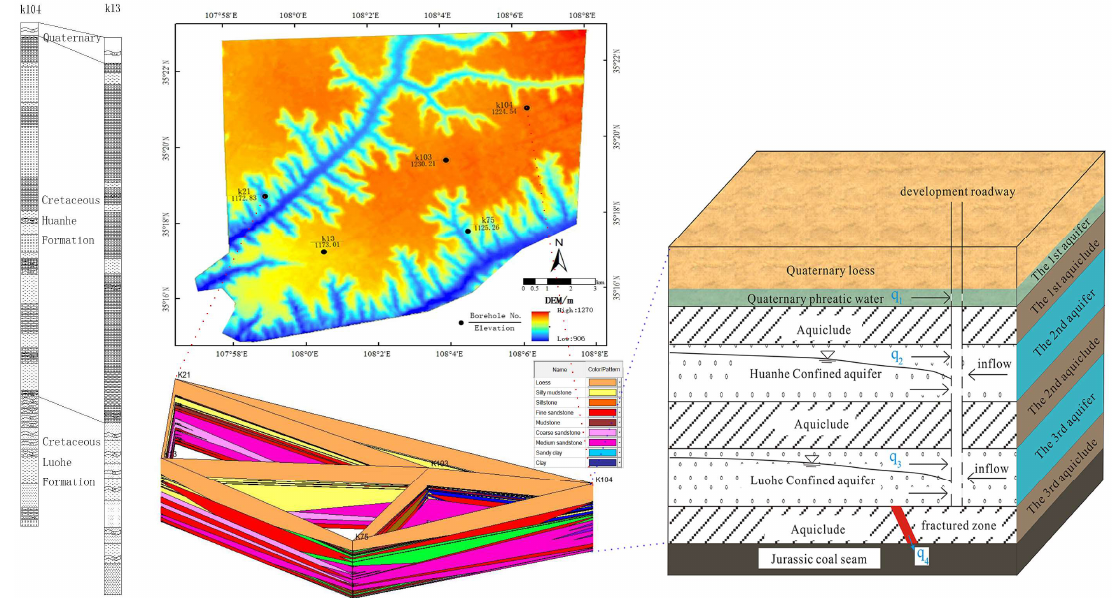
Figure 3. Diagram of the hydrogeological section of the mining area.